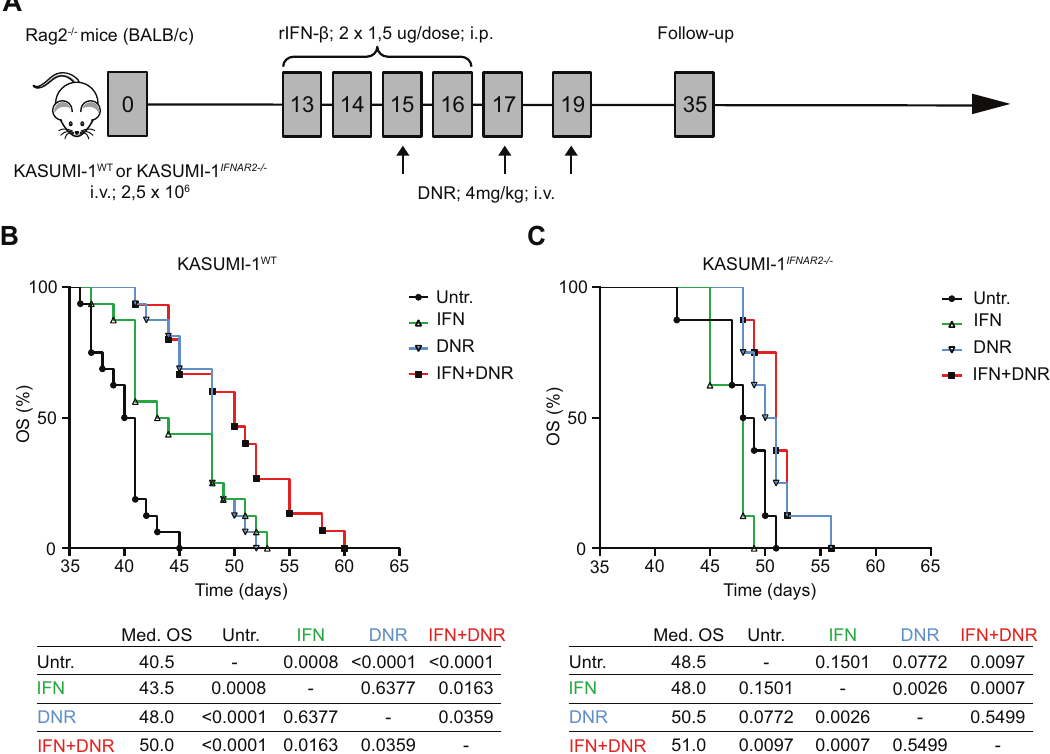
Fig. 4 Chemosensitizing effects of type I IFN in human AML xenografts. A Experimental study design of an AML xenograft model using human WT or IFNAR2 -/- KASUMI-1 cells in Rag2 -/- mice. B Overall survival (OS) of Rag2 -/- mice xenografted with WT KASUMI-1 cells and optionally treated with human rIFN- β (IFN), daunorubicin (DNR) or IFN + DNR. C OS of Rag2 -/- mice xenografted with IFNAR2 -/- KASUMI-1 cells and optionally treated with IFN, DNR or IFN + DNR. Survival curves were estimated by the Kaplan-Meier method, and differences between groups were evaluated using log-rank test. Median OS (days) and p values are